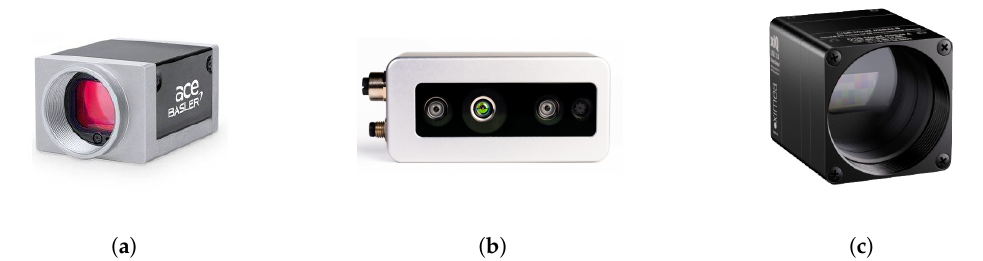
Figure 3. The multi-camera system composed of ( a ) RGB, ( b ) 3D, and ( c ) multispectral